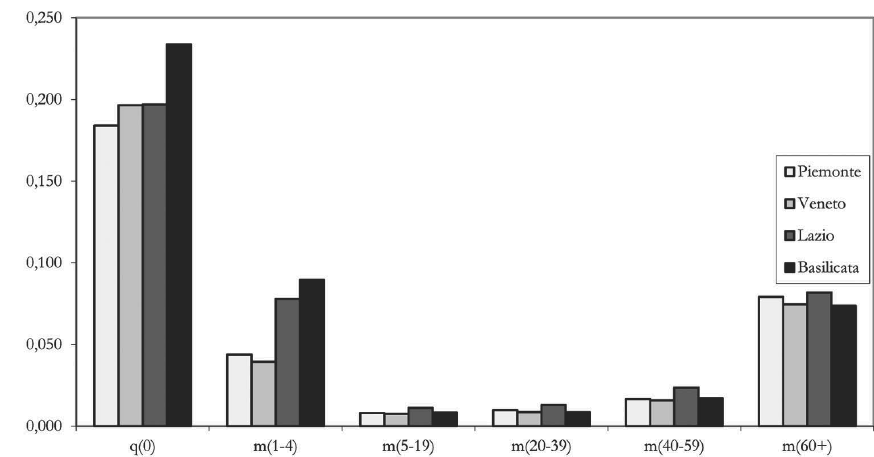
Figura 2 – Age specific mortality rates (both sexes) in four Italian regions (1888).